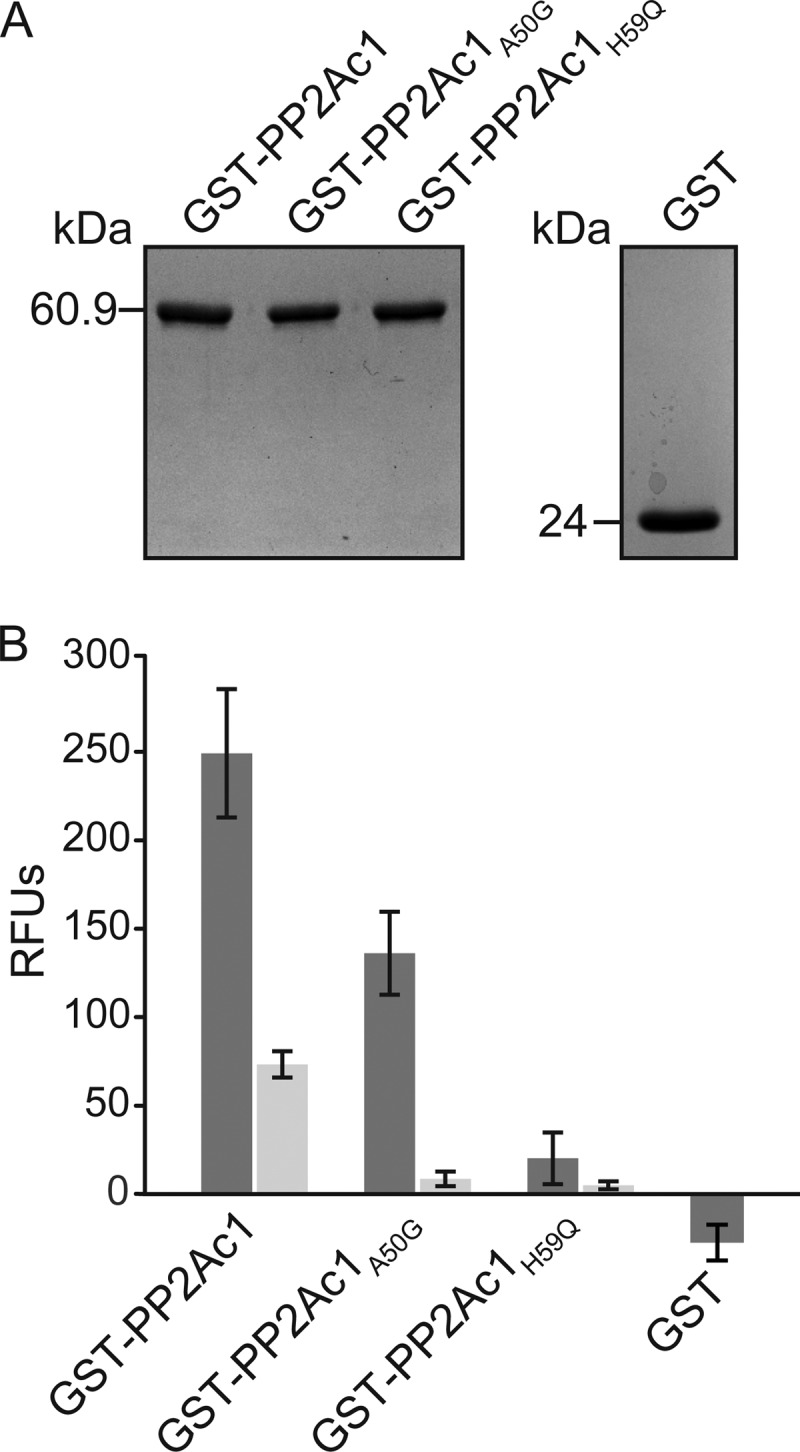
In vitro phosphatase activity of PP2Ac1. (A) GST-PP2Ac1, GST-PP2Ac1A50G, GST-PP2Ac1H59Q, and GST were purified from E. coli. (B) RFU caused by dephosphorylation of DiFMUP by PP2Ac1, PP2Ac1A50G, PP2Ac1H59Q (n = 9), and GST (n = 6) without okadaic acid (dark gray) and with okadaic acid (light gray; n = 6). Error bars indicate the standard deviations of the experiments shown.